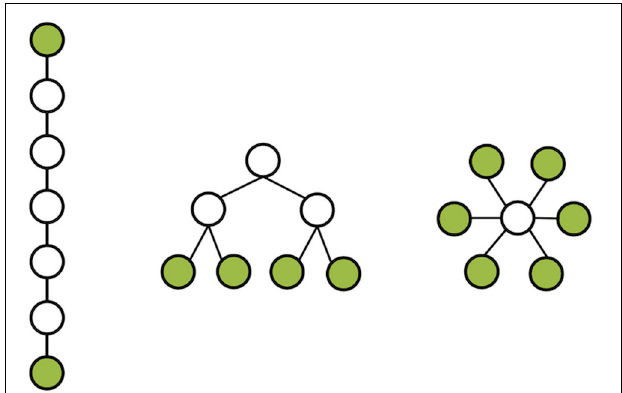
FIGURE 2 | Three network topologies based on MST network. On the left a path-like topology with few leafs and long diameter; on the right a star-like topology with many leaves and a moderate diameter. In the middle an intermediate form combining the qualities of a line-like and star-like topology. Notify that all networks have the same number of nodes and connections. Leafs colored in